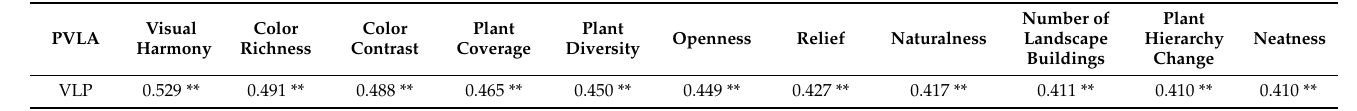
Table 6. Spearman correlation between visual landscape preference (VLP) and perceived visual landscape attributes